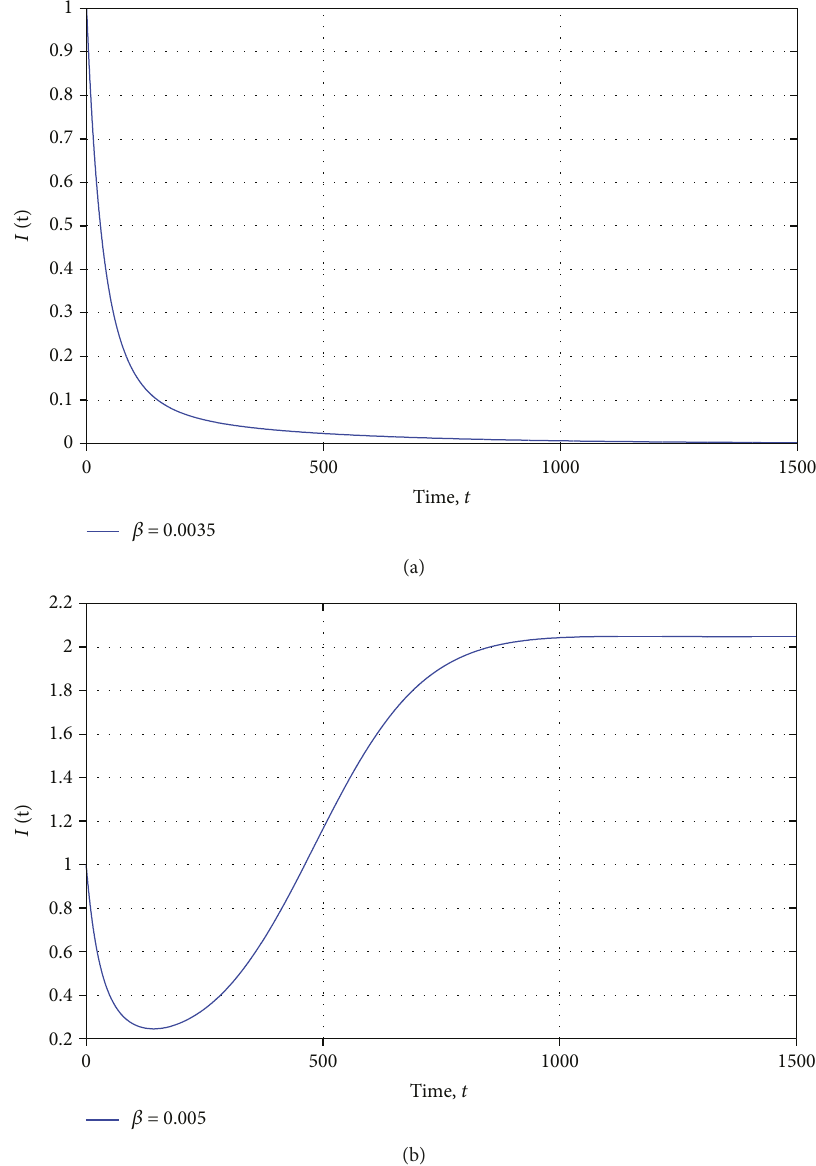
≃ 0 9149 < 1 . (b) β = 0 0005 0